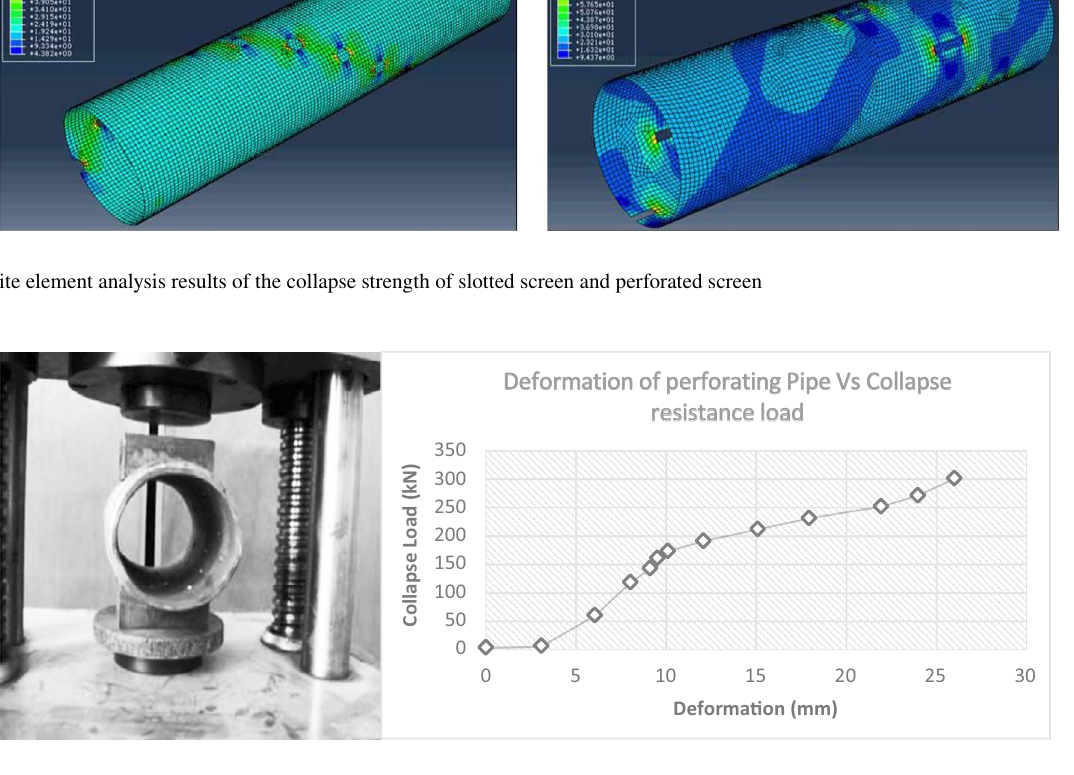
Fig. 5 Collapse resistance load of perforated